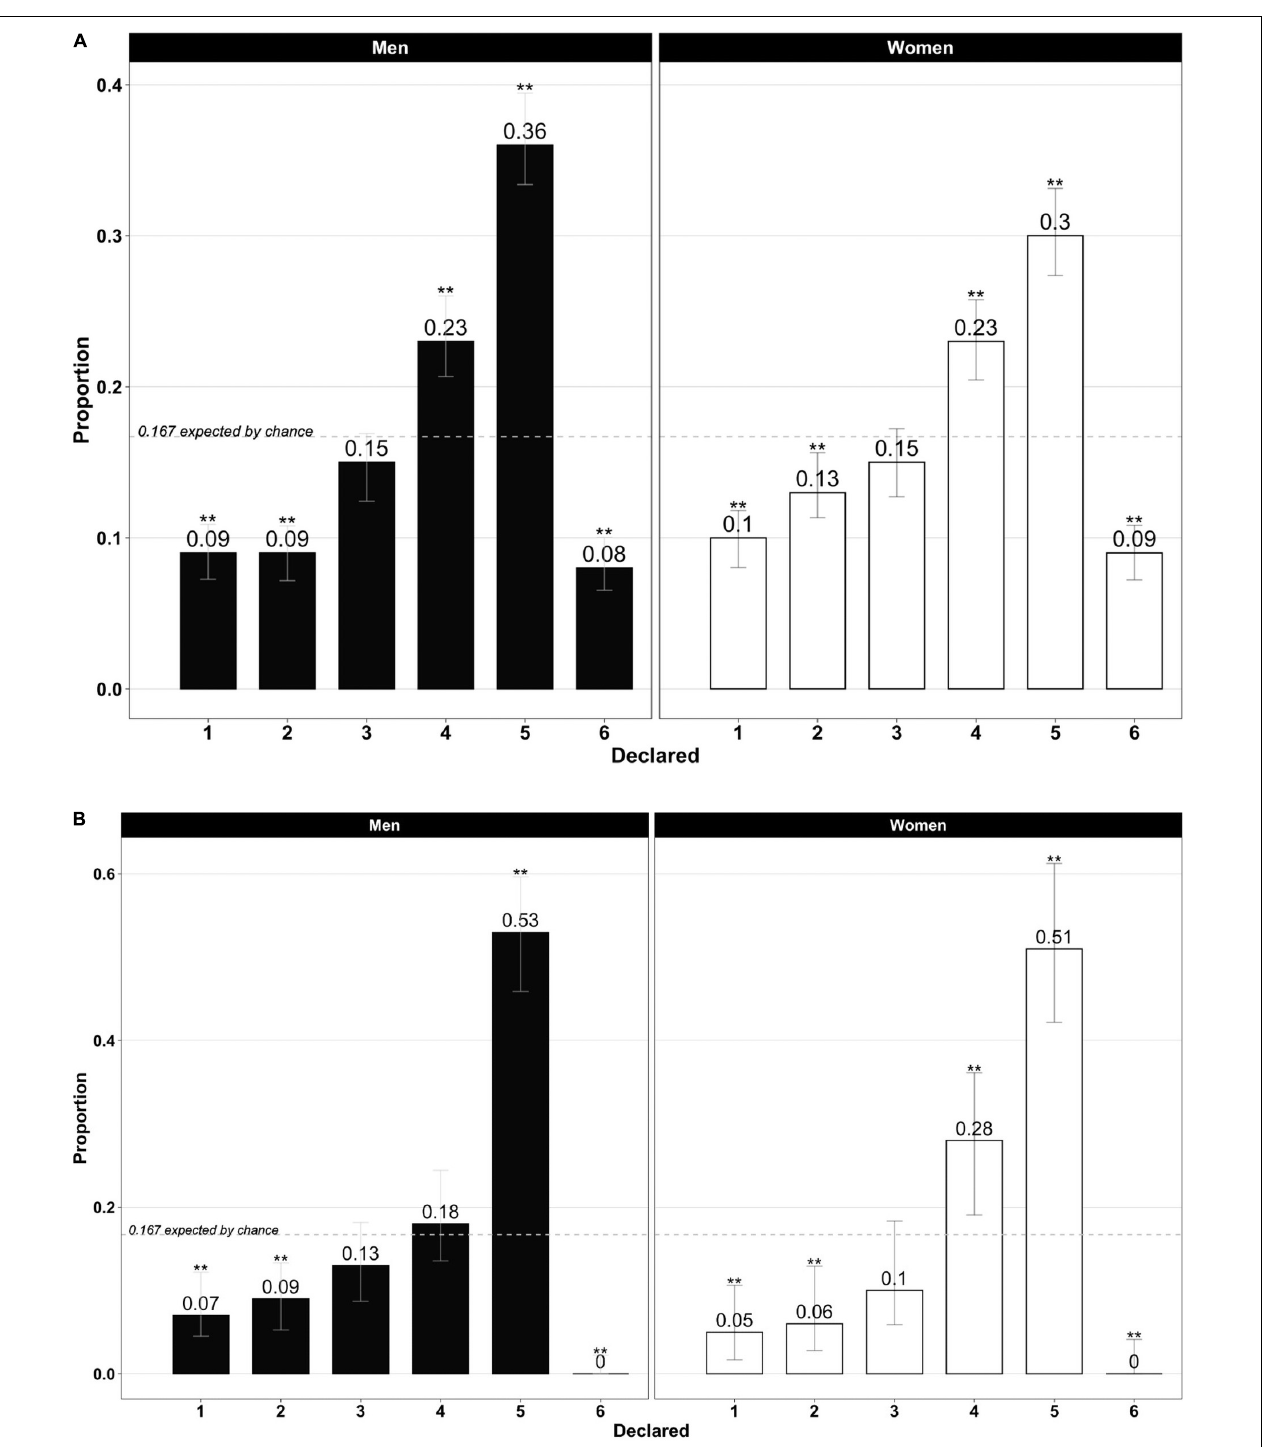
FIGURE 1 | (A) Declared die outcome (men vs. women). Proportion test confidence interval at 95% is represented in gray. Asterisks above the confidence interval mean significant differences between the observed and expected distribution by chance. ** p < 0.01; * p < 0.05. (B) Declared die outcome (men vs. women in excluded participants). Proportion test confidence interval at 95% is represented in gray. Asterisks above the confidence interval mean significant differences between the observed and expected distribution by chance. ** p < 0.01; * p <